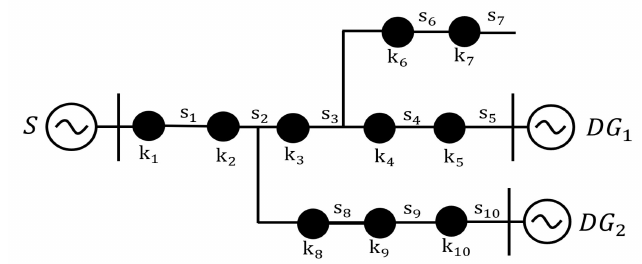
Figure 2. Multi-branch distribution network model.